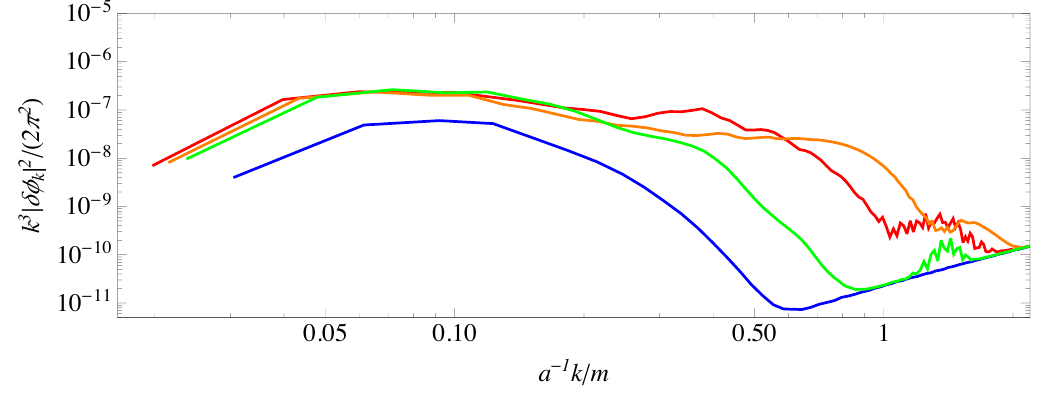
Figure 7 . The spectrum of (cid:12)eld (cid:13)uctuations k 3 j (cid:14)(cid:30) k j 2 = (2 (cid:25) 2 ) as a function of the physical momentum a (cid:0) 1 k=m . The results originate from a lattice simulation of the KKLT model with W 0 = 10 (cid:0) 5 with 512 3 points. The di(cid:11)erent colours correspond to the following moments in time: shortly after the end of the linear regime a = 4 : 98 (blue), a = 6 : 41 (green), a = 7 : 07 (orange) and at the end of the simulation a = 8 : 3